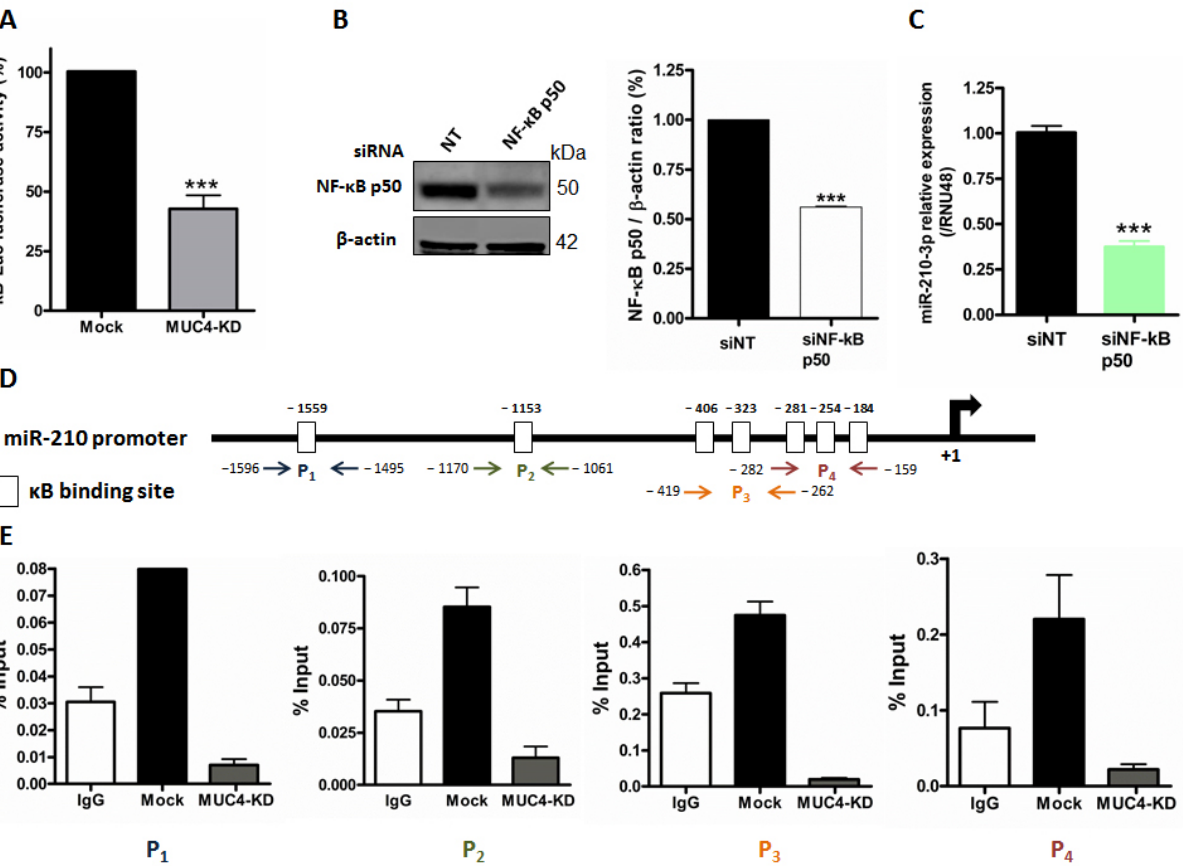
Figure 3. MUC4 regulates miR-210 expression through NF- κ B pathway. ( A ) Luciferase activity of the κ B-Luc synthetic reporter construct was measured 48 h following transient transfection in Mock and MUC4-KD PANC89 cells. Luciferase activity in Mock cells was set as 100%. *** indicates statistical significance compared to mock cells ( p < 0.001). Three independent experiments were performed. ( B ) Western blotting analysis of NF- κ B p50 and β -actin expression in siNF- κ B p50 transfected cells and corresponding siNT control. P50/ β -actin ratio is indicated on the histogram. ( C ) RT–qPCR analysis of miR-210-3p relative expression in NF- κ B siRNA (siNF- κ B p50)-transfected PANC89 cells. Expression in siNT control cells was arbitrarily set to 1. *** indicates statistical significance compared to siNT control cells ( p < 0.001). Three independent experiments were performed. ( D ) miR-210 promoter schematic representation. κ B predicted binding sites are indicated with white boxes. Four primer pairs ( p ) were used for ChIP assays and are indicated with colored arrows. ( E ) Chromatin immunoprecipitation of miR-210 promoter regions (P1[ − 1596/ − 1496], P2[ − 1070/ − 1061], P3[ − 419/ − 262] and P4[ − 282/ − 159] with NF- κ B p50. Chromatin enrichment was normalized to the input. Three independent experiments were performed.